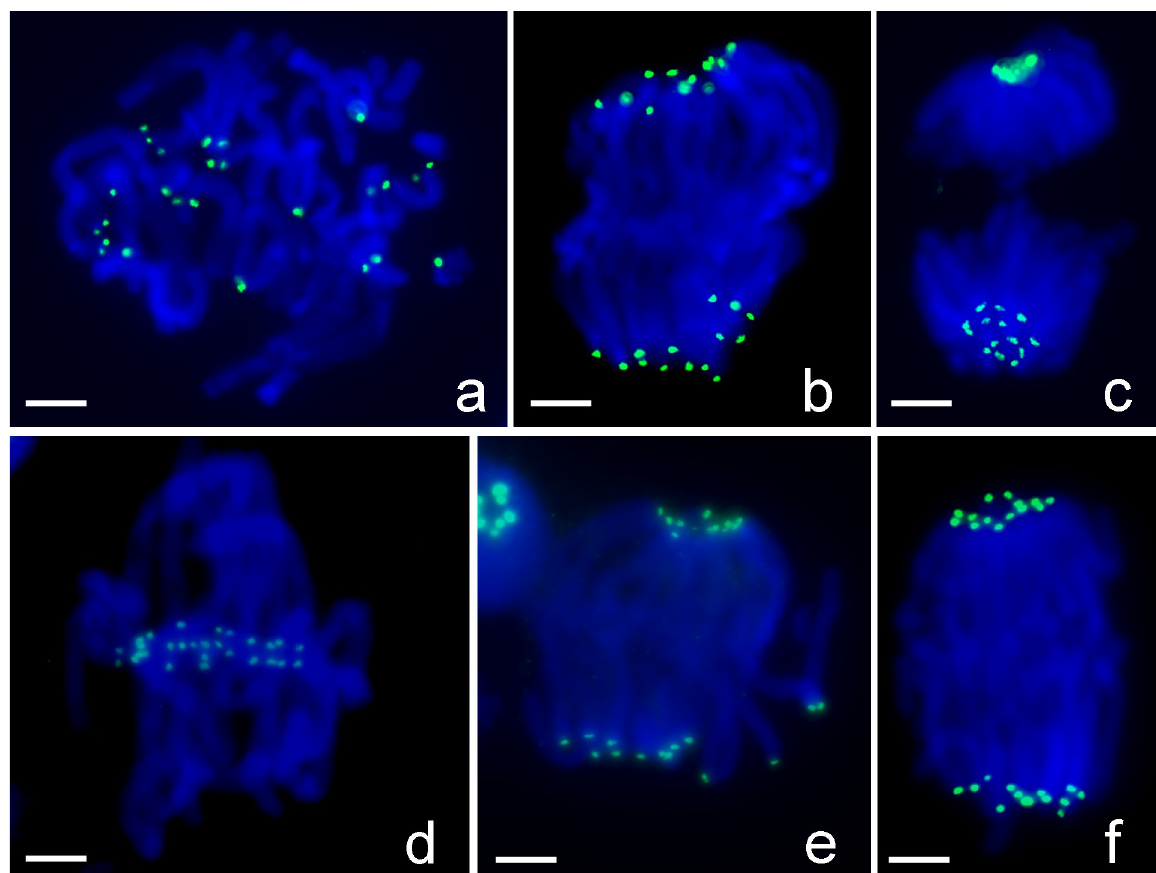
Fig 6. Immunostaining with anti-LaCENH3 antibody visualizing centromeres on chromosomes at mitotic metaphase and anaphase. (Scale bar = 10 μ m). Immunofluorescence signals (green) indicate the centromere locations of chromosomes (blue). (a-d) Artificial hybrid L . aurea × L . radiata (2n = 18, 4M+3T+11A), (e-f) L . radiate (2n = 22A); (a, d) Metaphase, (b, e, f) Anaphase, (c) Telophase.